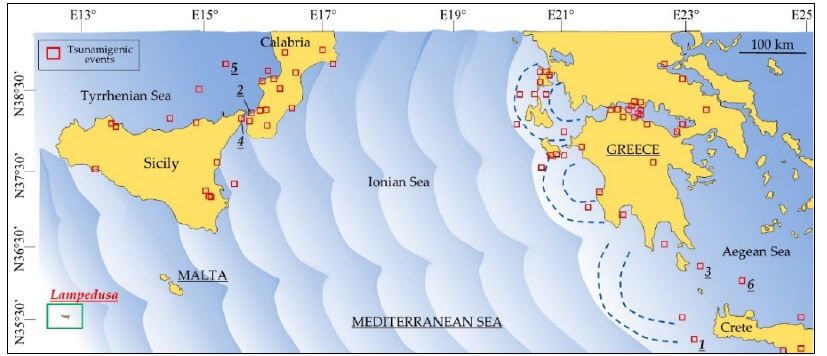
Figure 1. Localization of the main tsunamigenic events of the last 1800 years with a schematic representation of the direction of the main wave fronts of expected tsunami propagation in the Mediterranean Sea (Euro-Mediterranean Tsunami Catalogue—EMTC). In the green box is the study area. Numbered events refer to Table 1. The wavy trend of the contours represents the direction of a possible wave-front propagation in the eastern Mediterranean